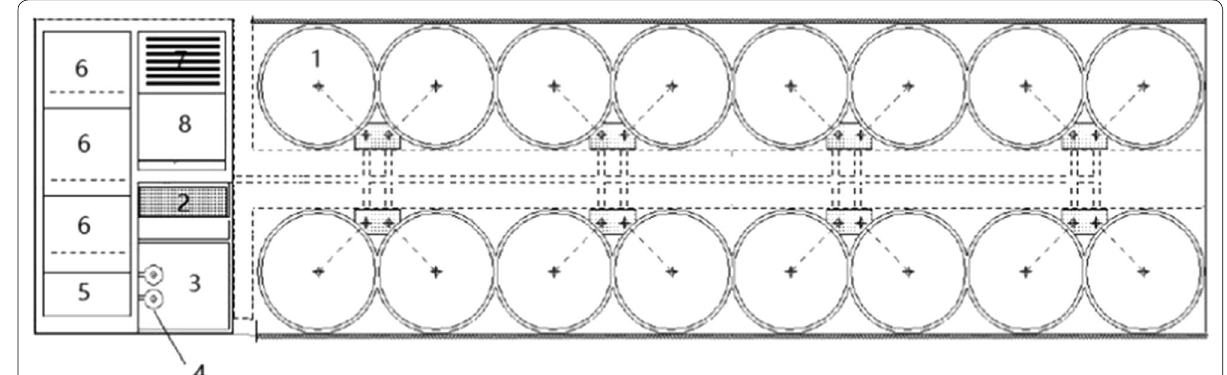
Fig. 1 Schematic diagram for RAS producing hybrid grouper ( Epinephelus lanceolatus are: (1) 16 fish rearing tanks, (2) a bowed screen, (3) a sump, (4) two pumps, (5) foam fractionators, (6) series of three biofilters, (7) UV disinfection unit, and (8) dissolved oxygen contact